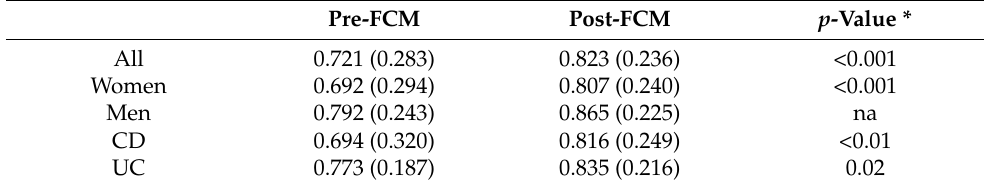
Table 4. Mean EQ-5D scores (SD).